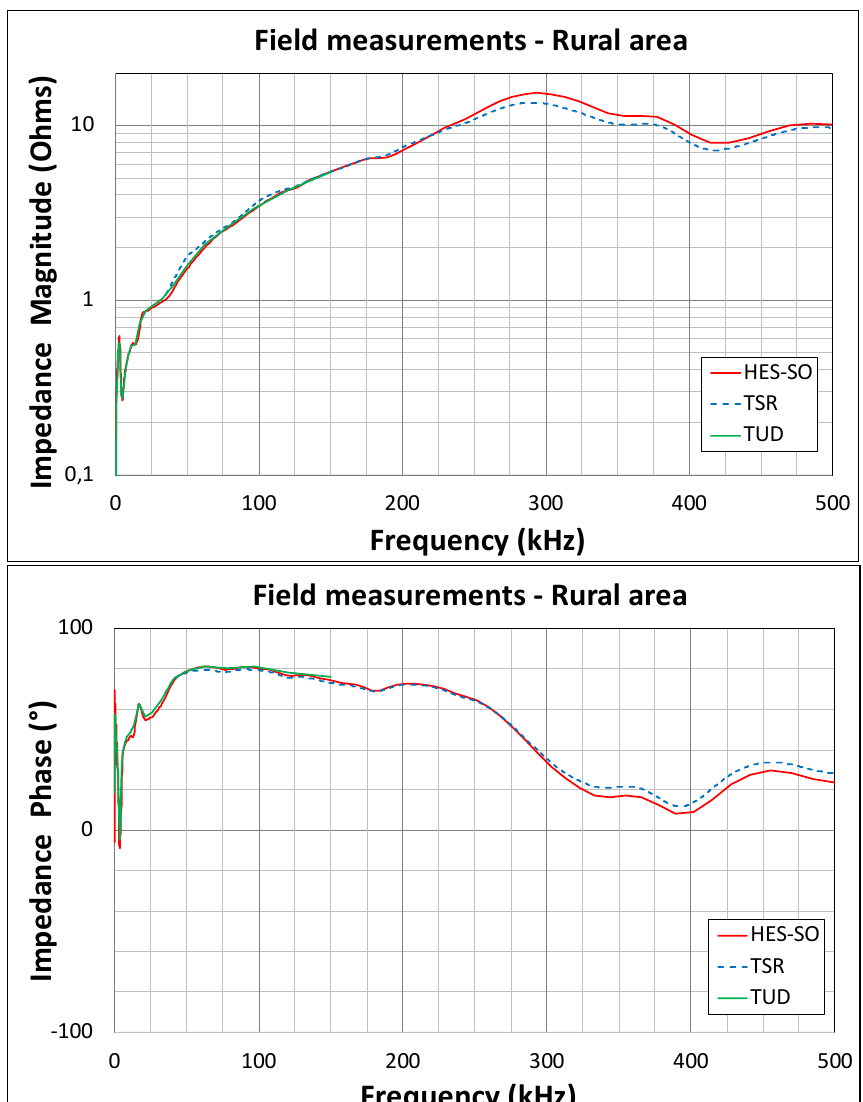
Figure 9. Example of the use of the measurement methods in field trials: (up) magnitude, (down) phase of the impedance.